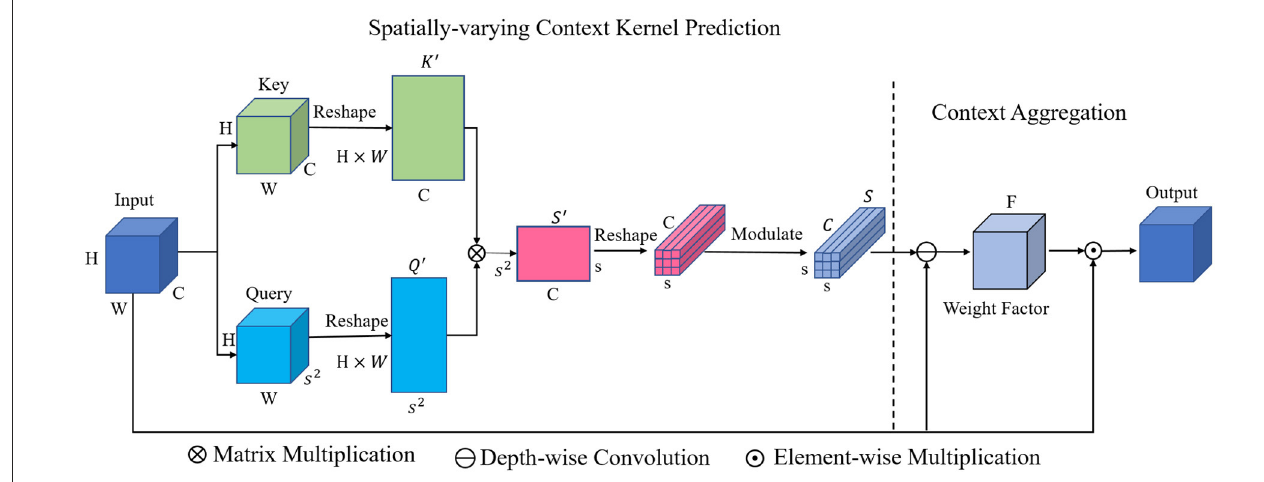
FIGURE2 Details of the proposed spatially-varying context aggregation module, which first predicts the spatially-varying context kernel and then aggregates the context with the predicted re-weight kernels.